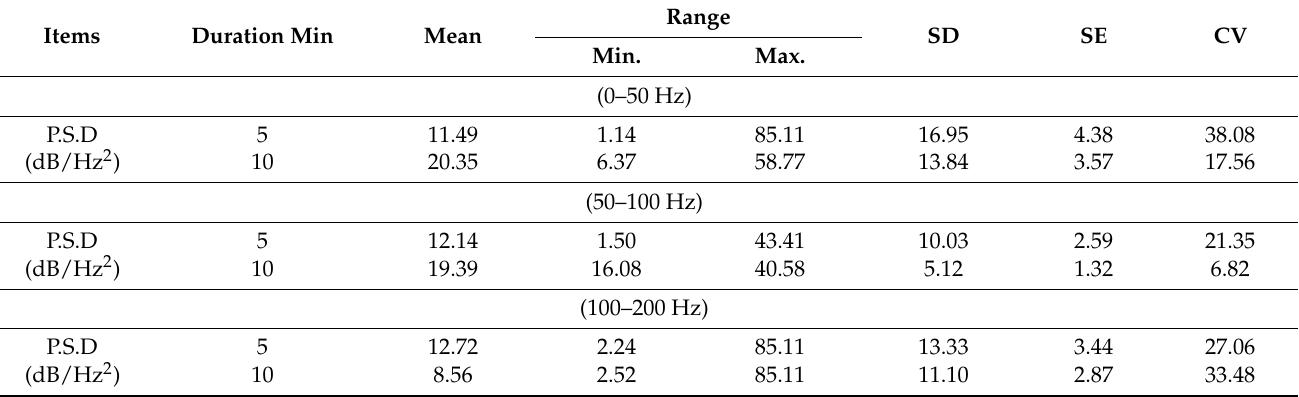
Table 3. Descriptive statistics of vibration analysis for cantaloupes in pattern packaging at different